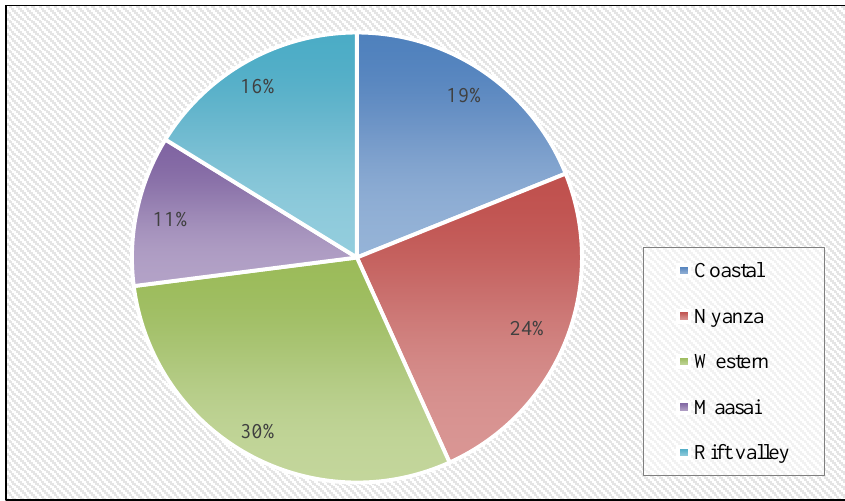
Figure 5. Respondent’s community